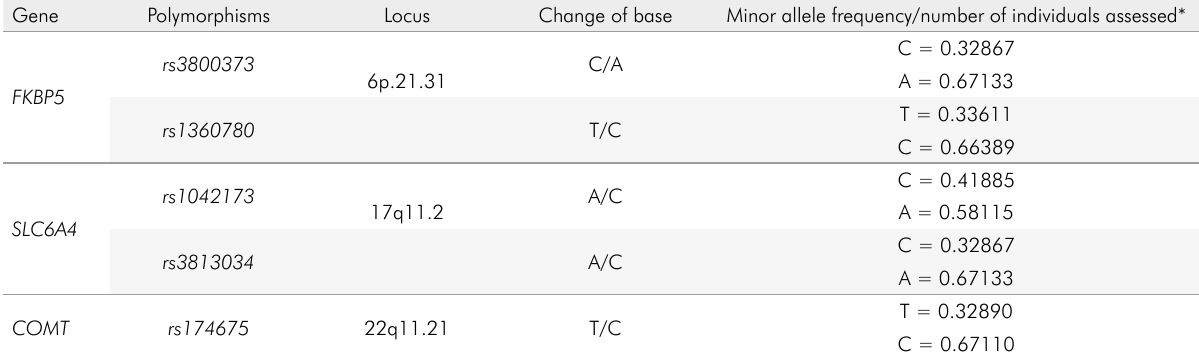
Table 1. Characteristics of the studied genetic polymorphisms.